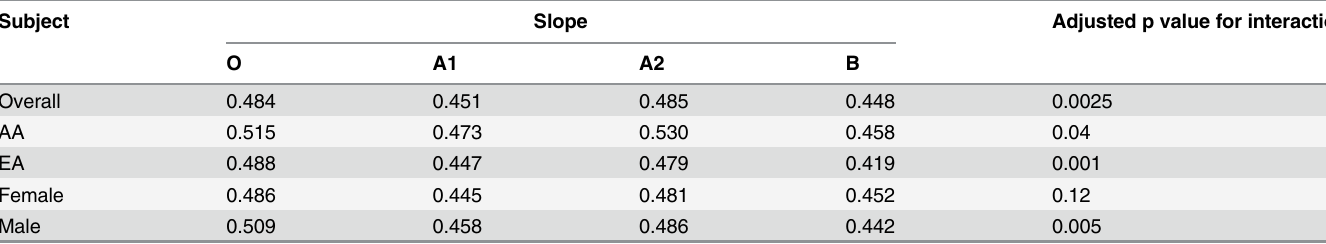
Table 7. Relationship between log FVIII and log VWF in homozygous ABO types * .